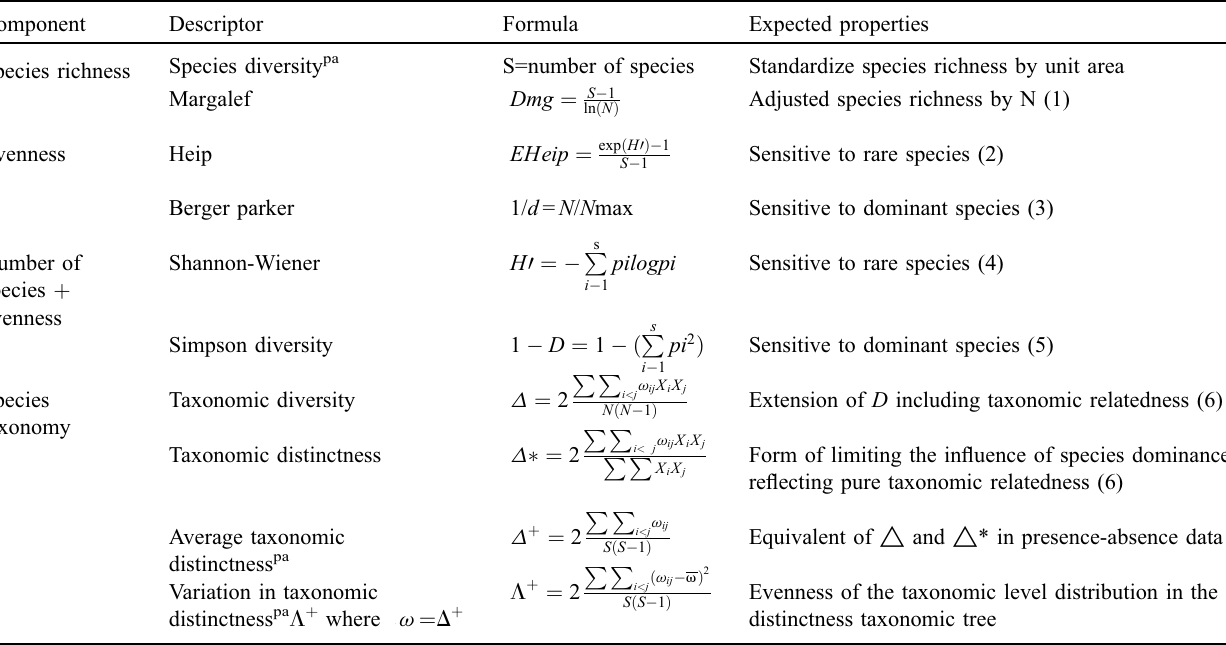
Table 1. The studied species diversity components and their descriptors. Indices based on presence-absence data are marked by pa .(1) Margalef (1958); (2) Heip (1974); (3) Berger and Parker (1970); (4) Shannon and Weaver (1949); (5) Simpson (1949); (6) Warwick and Clarke (1995); (7) Clarke and Warwick (2001).